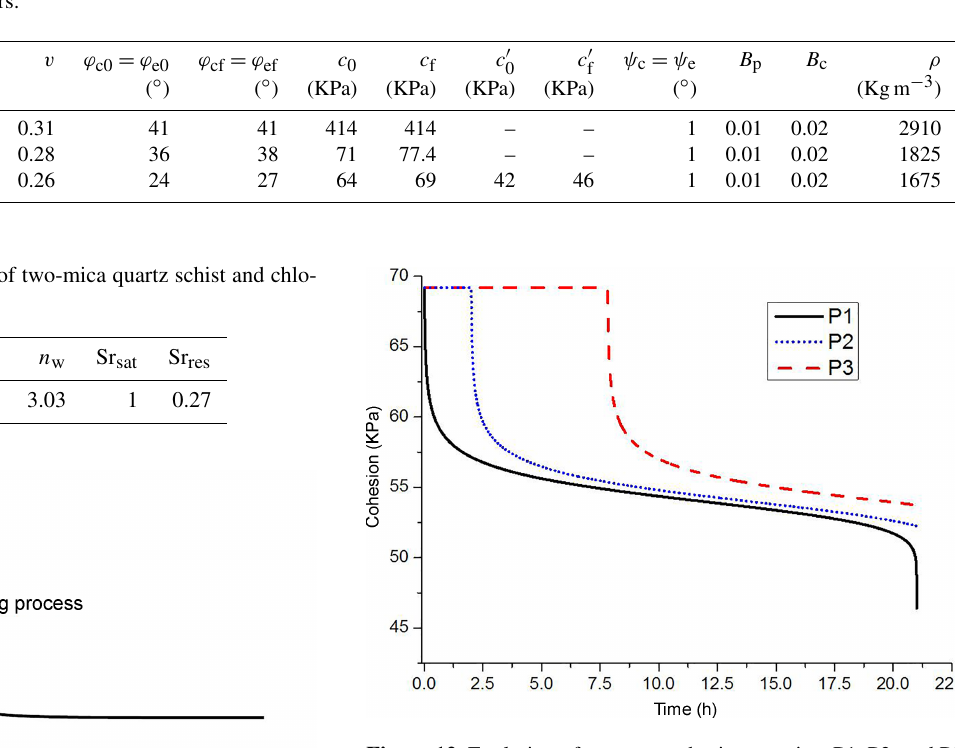
Table 1. Elastoplastic parameters.